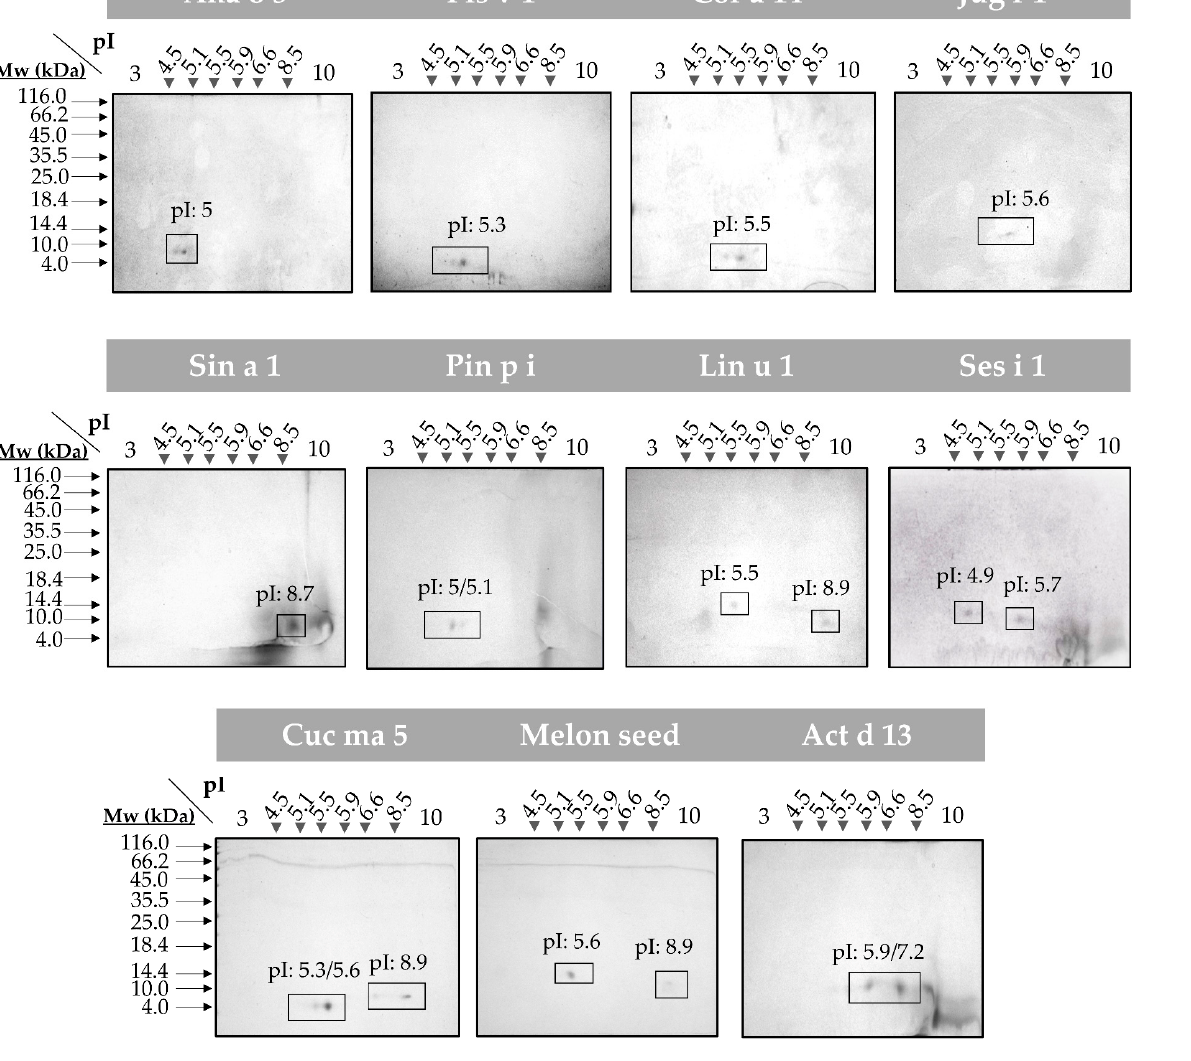
Figure 2. 2D SDS-PAGE of the isolated 2S albumins. Spots corresponding to isolate protein polypeptide chain isoforms are boxed. Isoelectric points (pI) of each isoform are indicated. Molecular mass markers (Mw) are indicated with arrows.